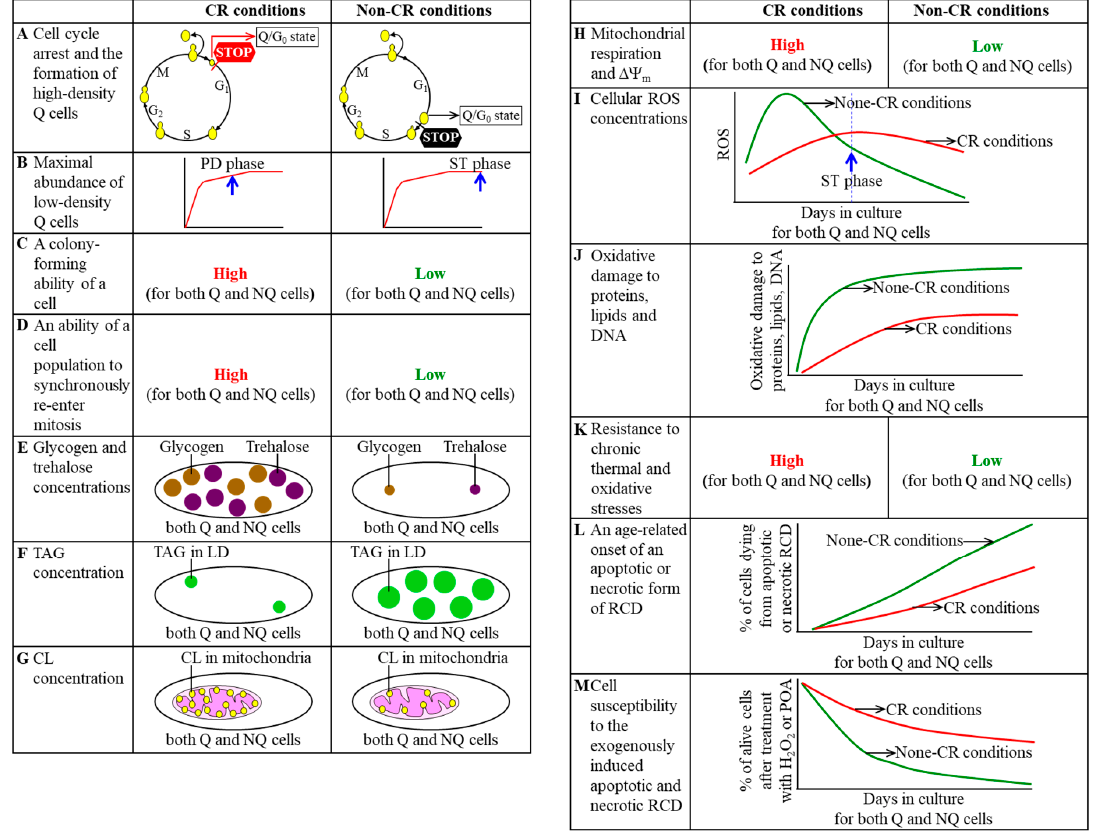
Figure 2. The caloric restriction (CR) diet alters an age-related chronology and specific traits of quiescent (Q) and non-quiescent (NQ) cell sub-populations. These aspects of an age-related chronology and these specific traits are named in di ff erent panels of the figure. They include the following: cell cycle arrest and the formation of high-density Q cells ( A ), maximal abundance of low-density Q cells ( B ), a colony-forming ability of a cell ( C ), an ability of a cell population to synchronously re-enter mitosis ( D ), glycogen and trehalose concentrations ( E ), triacylglycerol (TAG) concentration ( F ), cardiolipin (CL) concentration ( G ), mitochondrial respiration and the electrochemical potential across the inner mitochondrial membrane ( ∆Ψ m) ( H ), cellular reactive oxygen species (ROS) concentrations ( I ), oxidative damage to proteins, lipids and DNA ( J ), resistance to chronic thermal and oxidative stresses ( K ), an age-related onset of an apoptotic or necrotic form of regulated cell death (RCD) ( L ) and cell susceptibility to the exogenously induced apoptotic and necrotic RCD ( M ). See the text for more details. Other abbreviations: CL, cardiolipins; LD, lipid droplets; POA, palmitoleic acid.